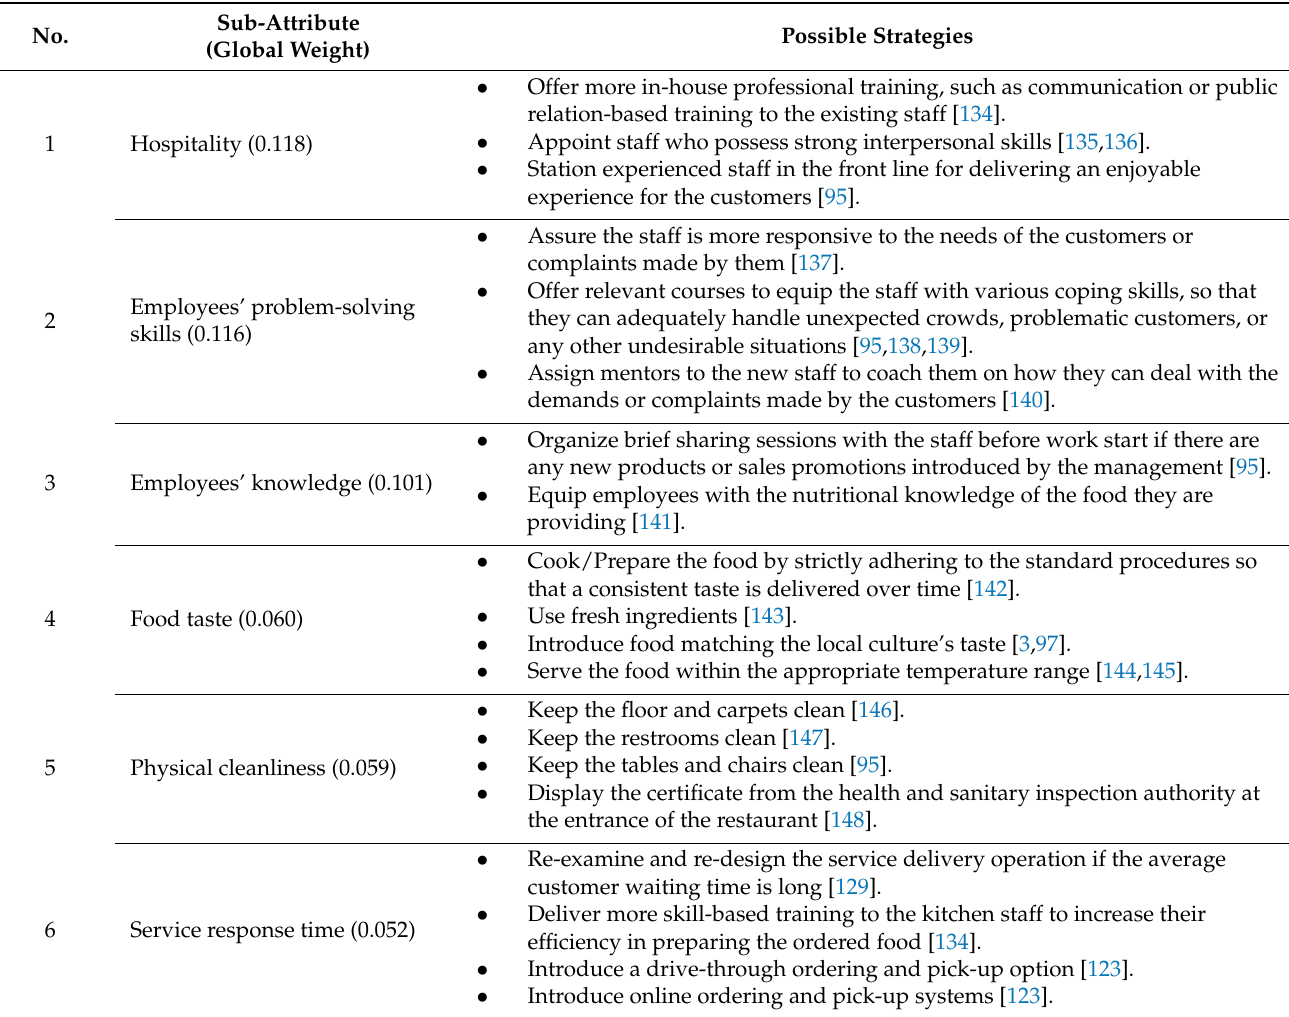
Table 6. Possible strategies for